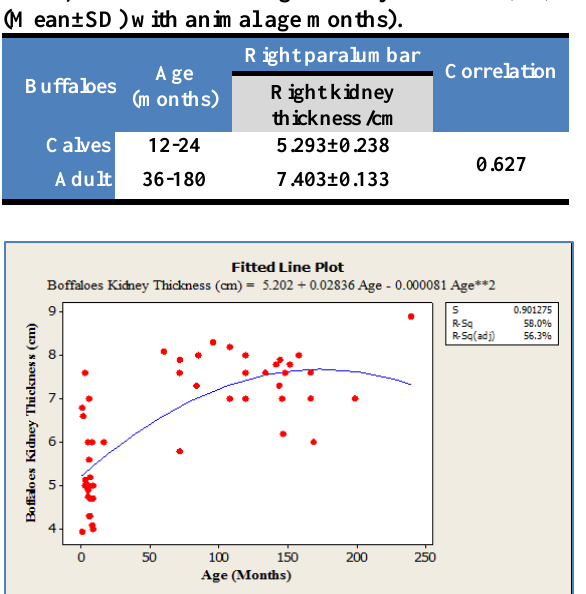
Figure, 9: Scatterplot describing the relationship between buffaloes right kidney thickness and the age. The solid line is the calculated linear regression